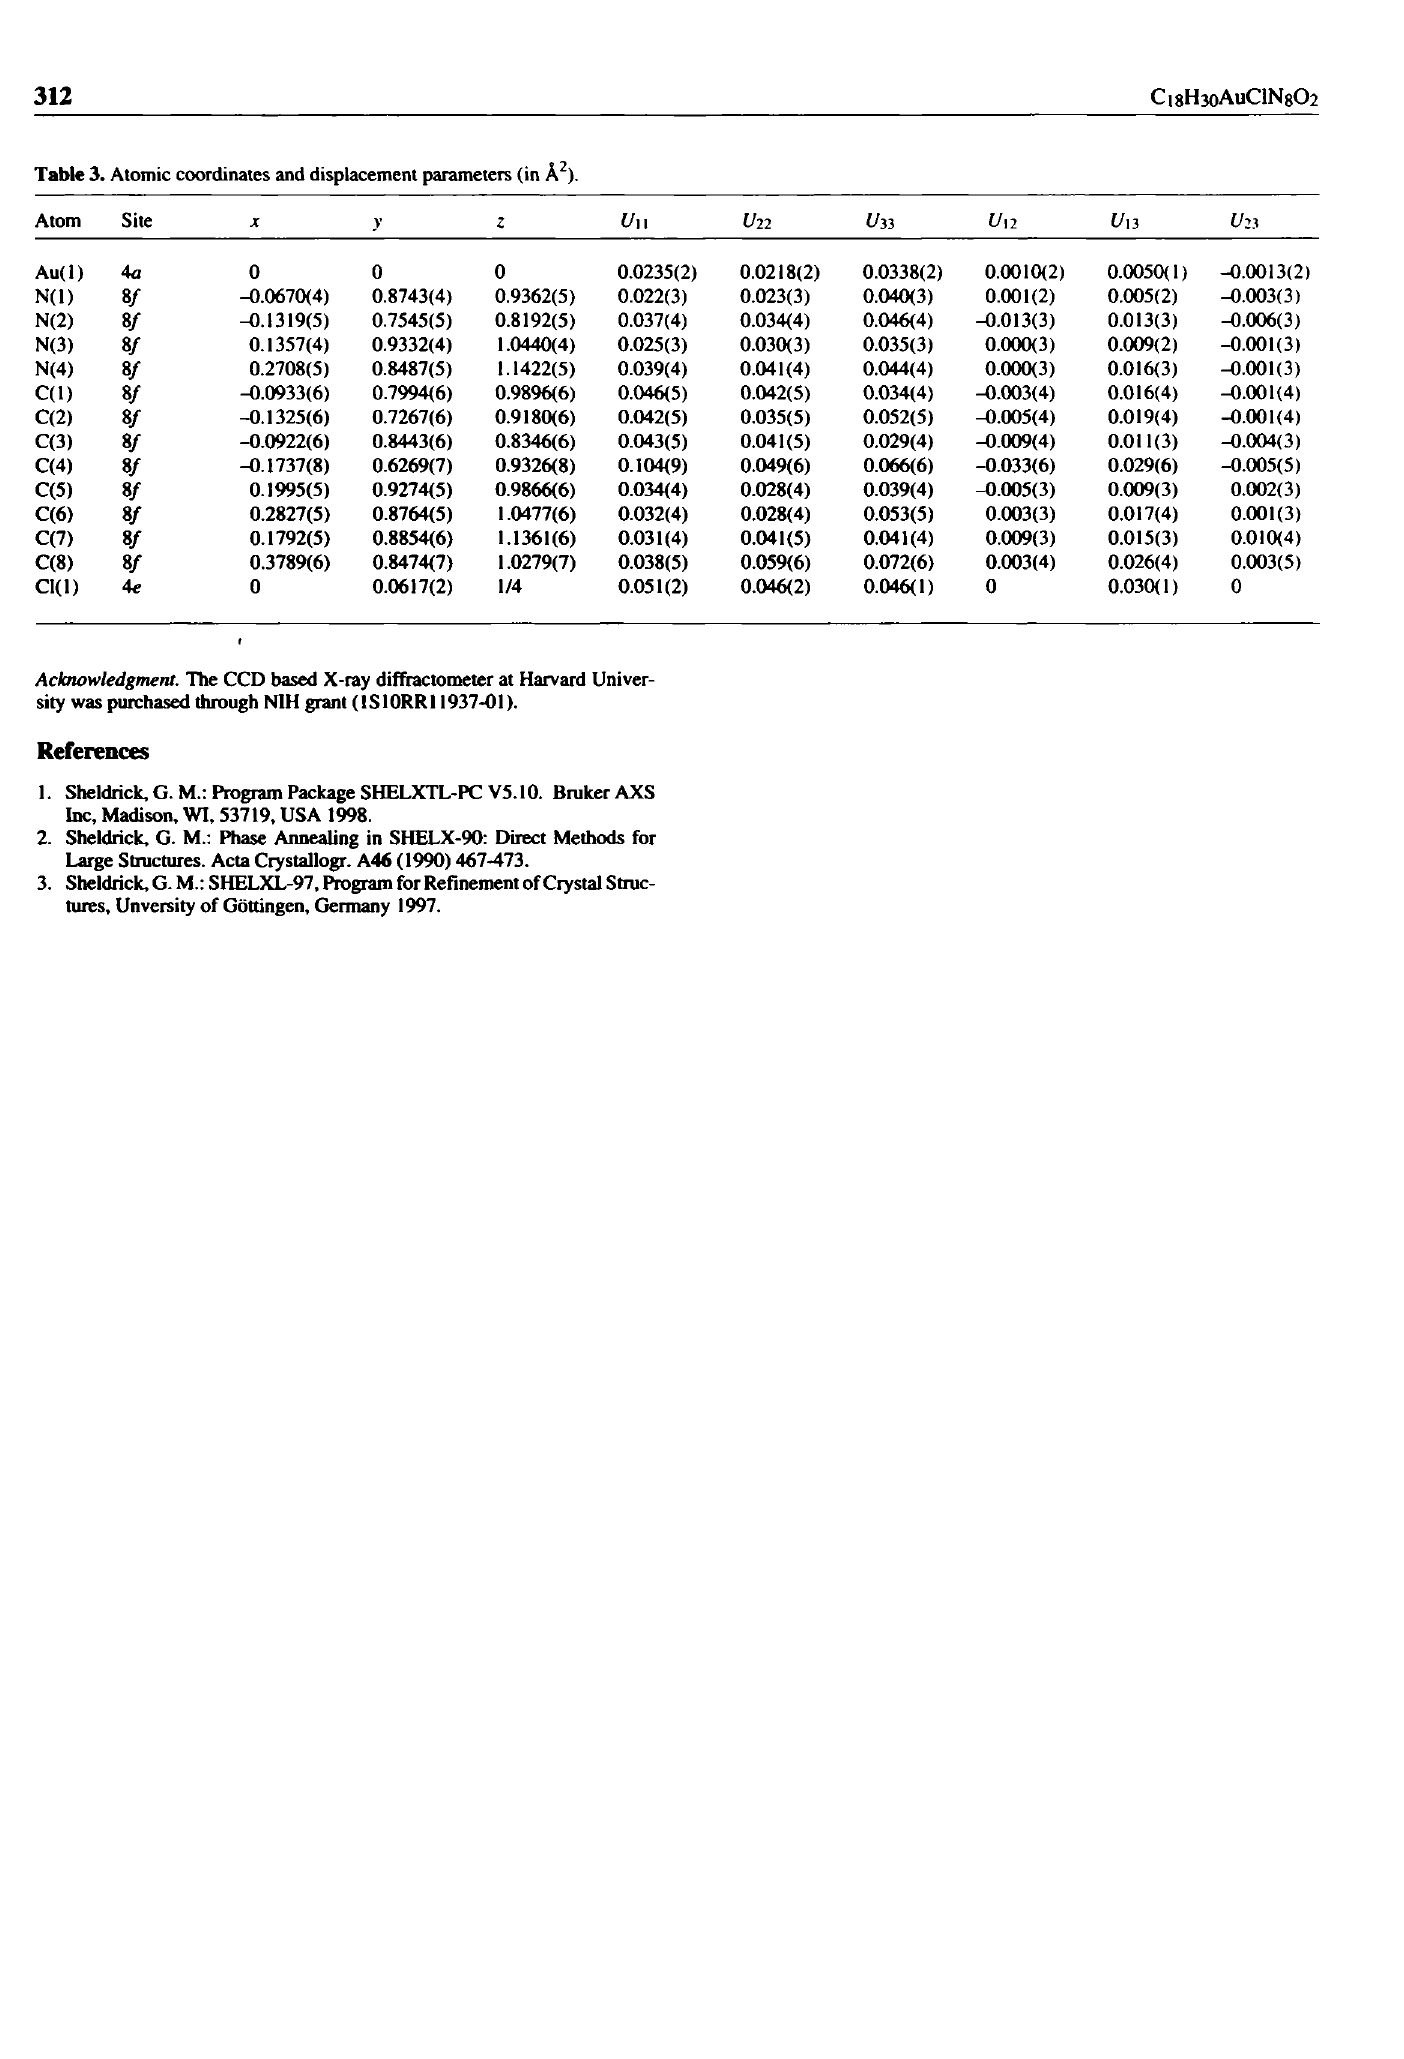
Table 3. Atomic coordinates and displacement parameters (in A 2